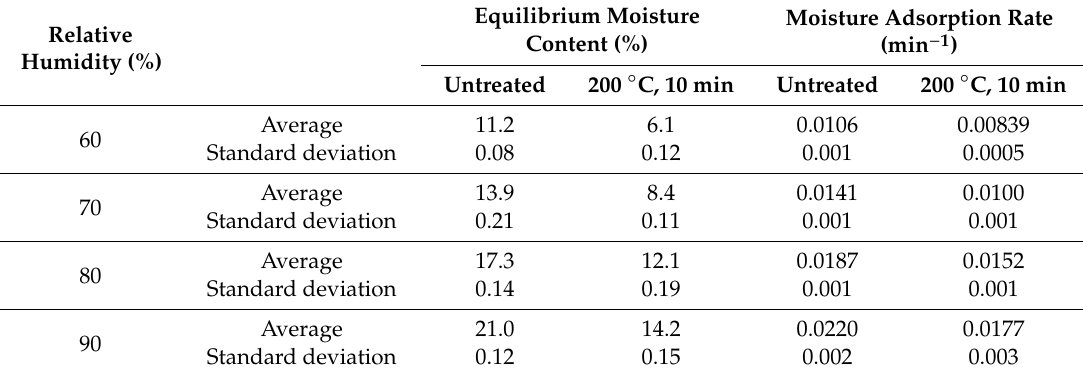
Table 3. Equilibrium moisture content and moisture adsorption constant of untreated and steam exploded straw samples in the controlled chamber set at 30 ◦ C and di ff erent relative